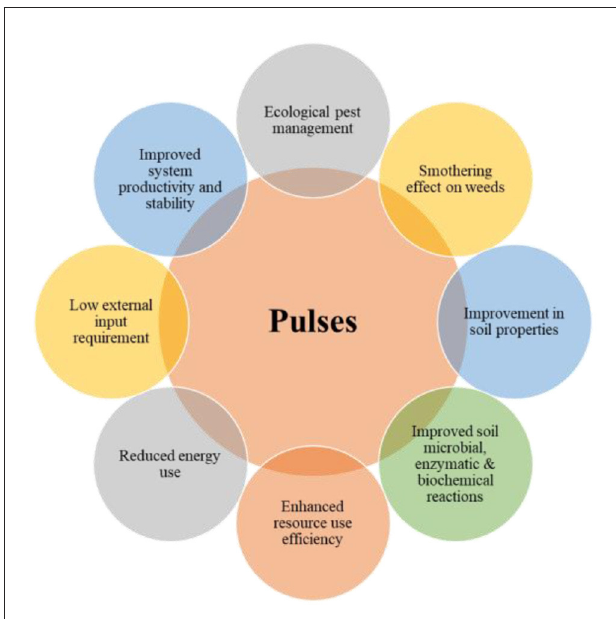
FIGURE9 Pulses for soil health restoration and ecosystem services (Modified, Rani et al.,